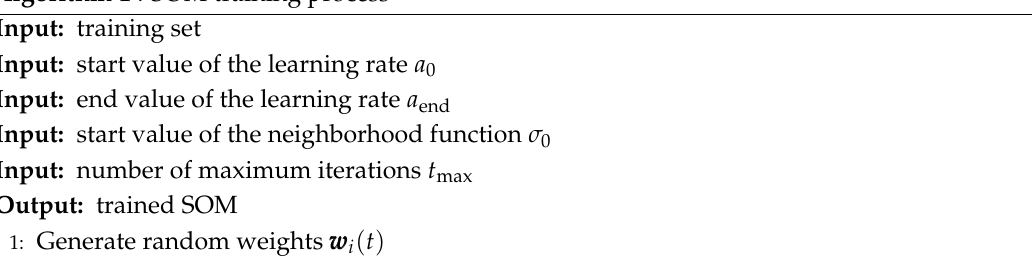
Algorithm 1 : SOM training